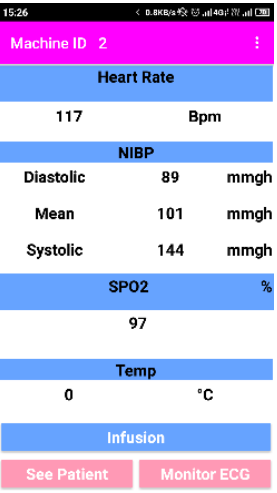
Figure 5. Vital Sign in Real View on Android